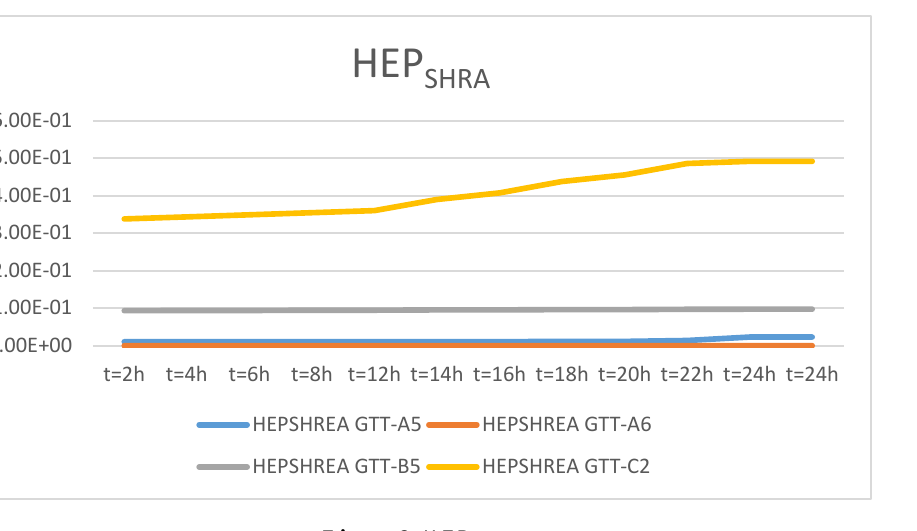
Figure 3. HEP SHRA